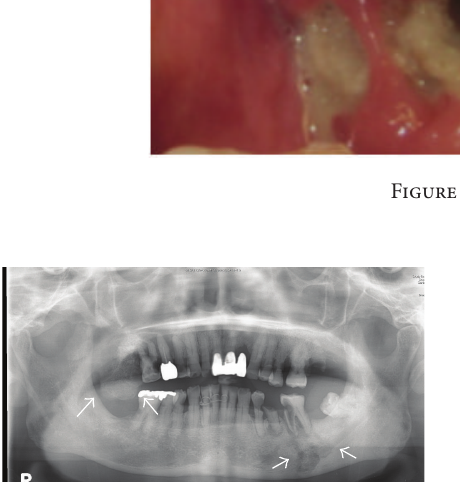
Figure 2: Preoperative panoramic radiograph.